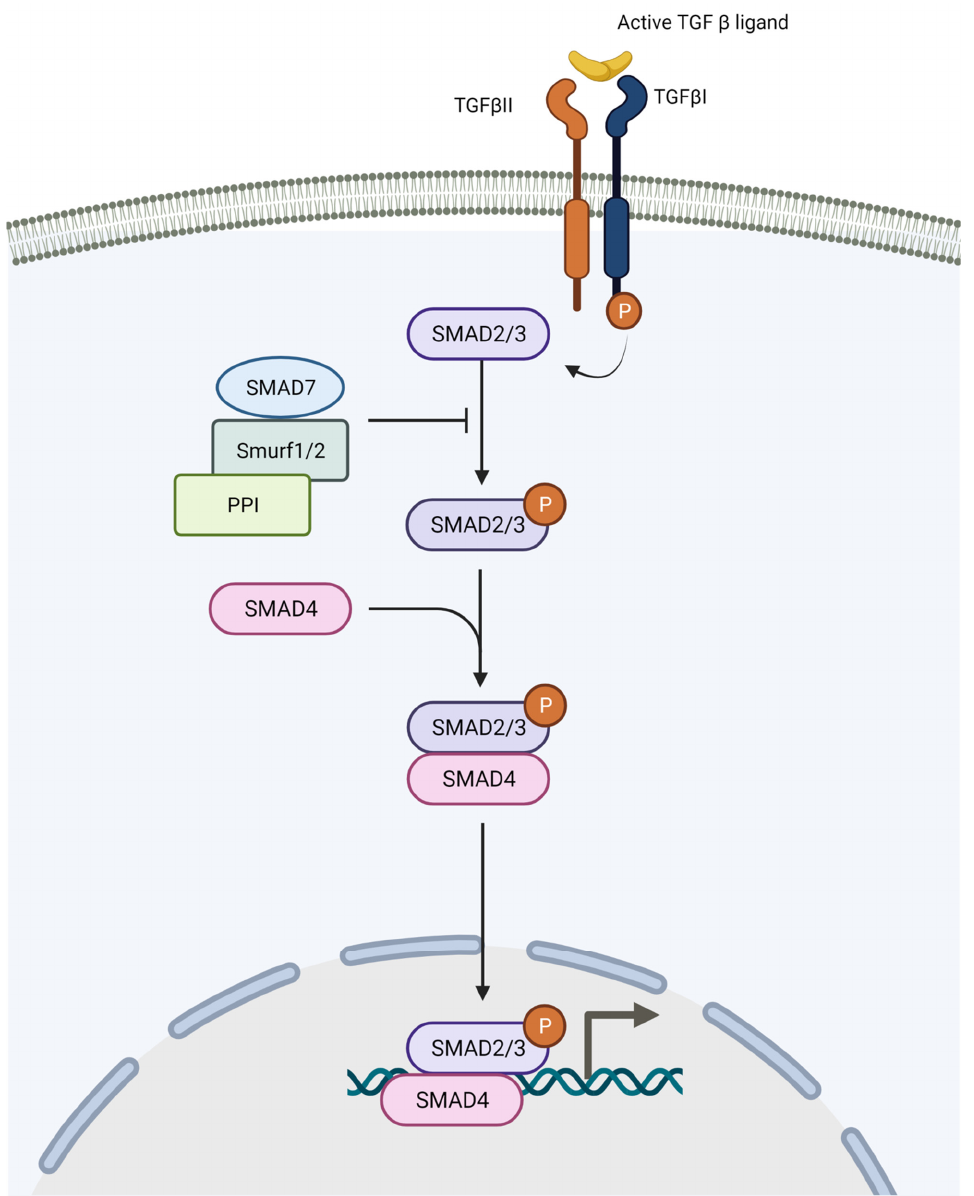
Figure 3. The TGF β signalling pathway. Upon binding of the TGF β ligand to the TGF β type II receptor, the latter phosphorylates the TGF β type I receptor which further phosphorylates SMAD2/SMAD3. Activated SMAD2/3 binds to SMAD4 and accumulates in the nucleus to regulate the transcription of target genes. SMAD7 acts as an inhibitor of TGF β signalling. It recruits phosphatase PP1 or ubiquitin ligases Smurf1, Smurf2, to induce dephosphorylation or proteasomal degradation of receptor complexes.